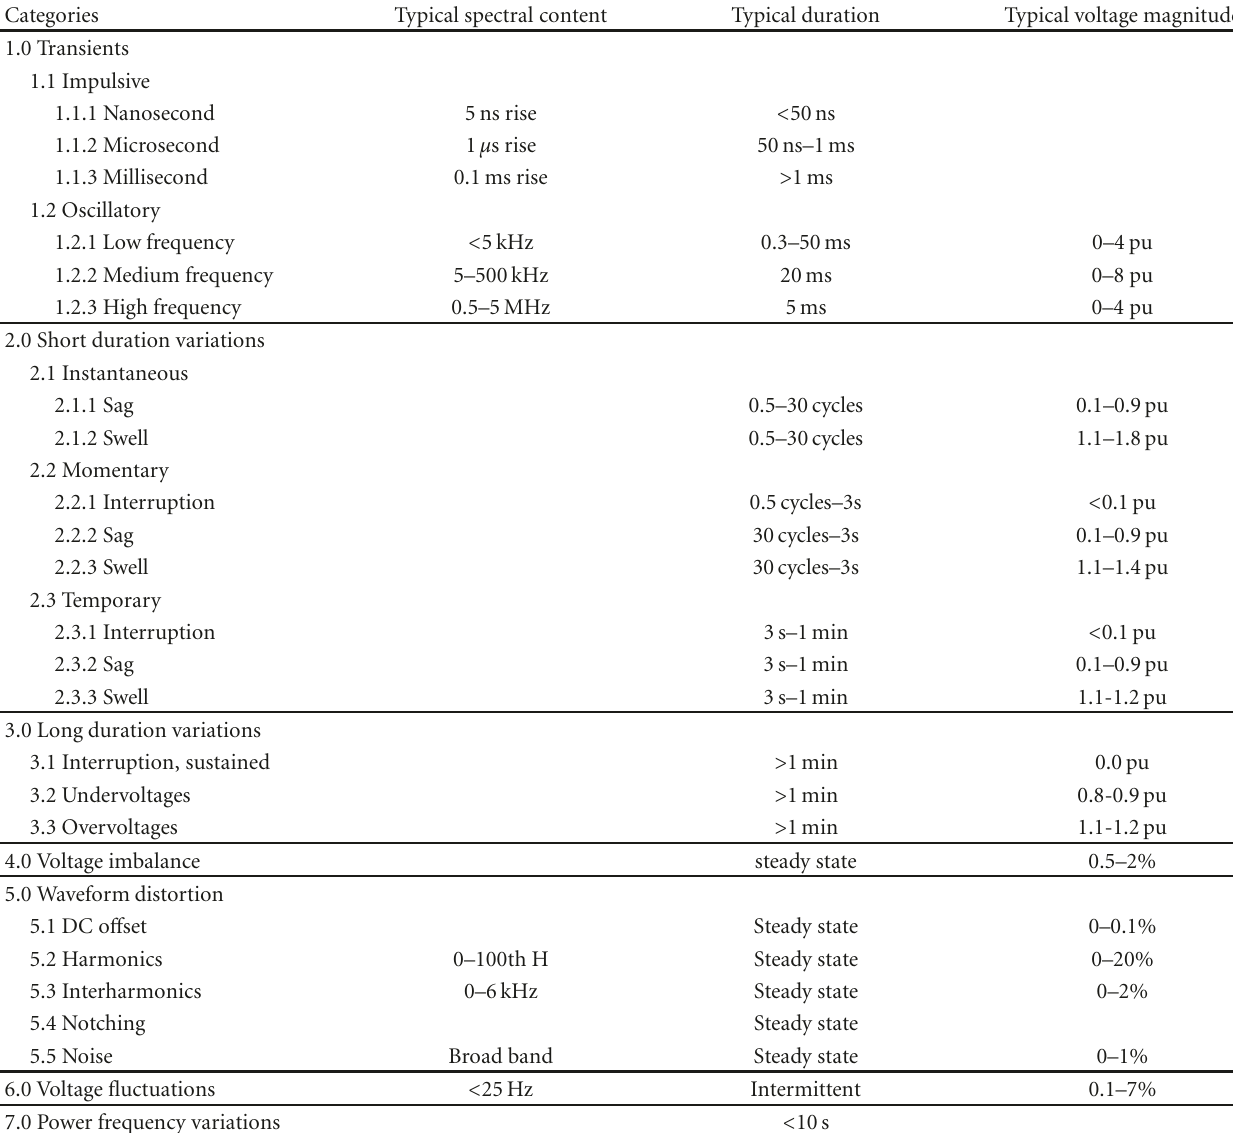
Table 1: Categories and typical characteristics of power system electromagnetic phenomena